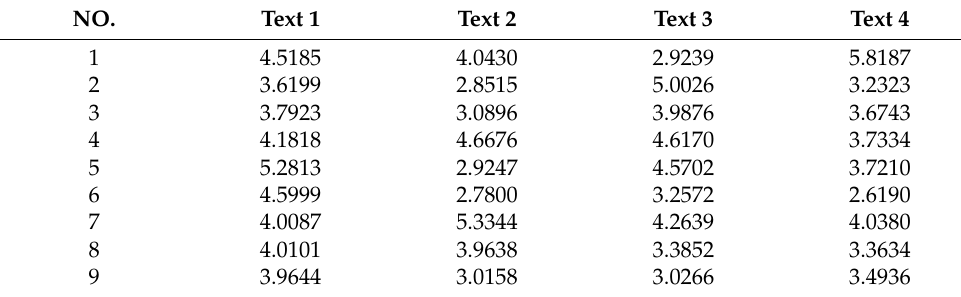
Table 6. Graph of surface hardness test